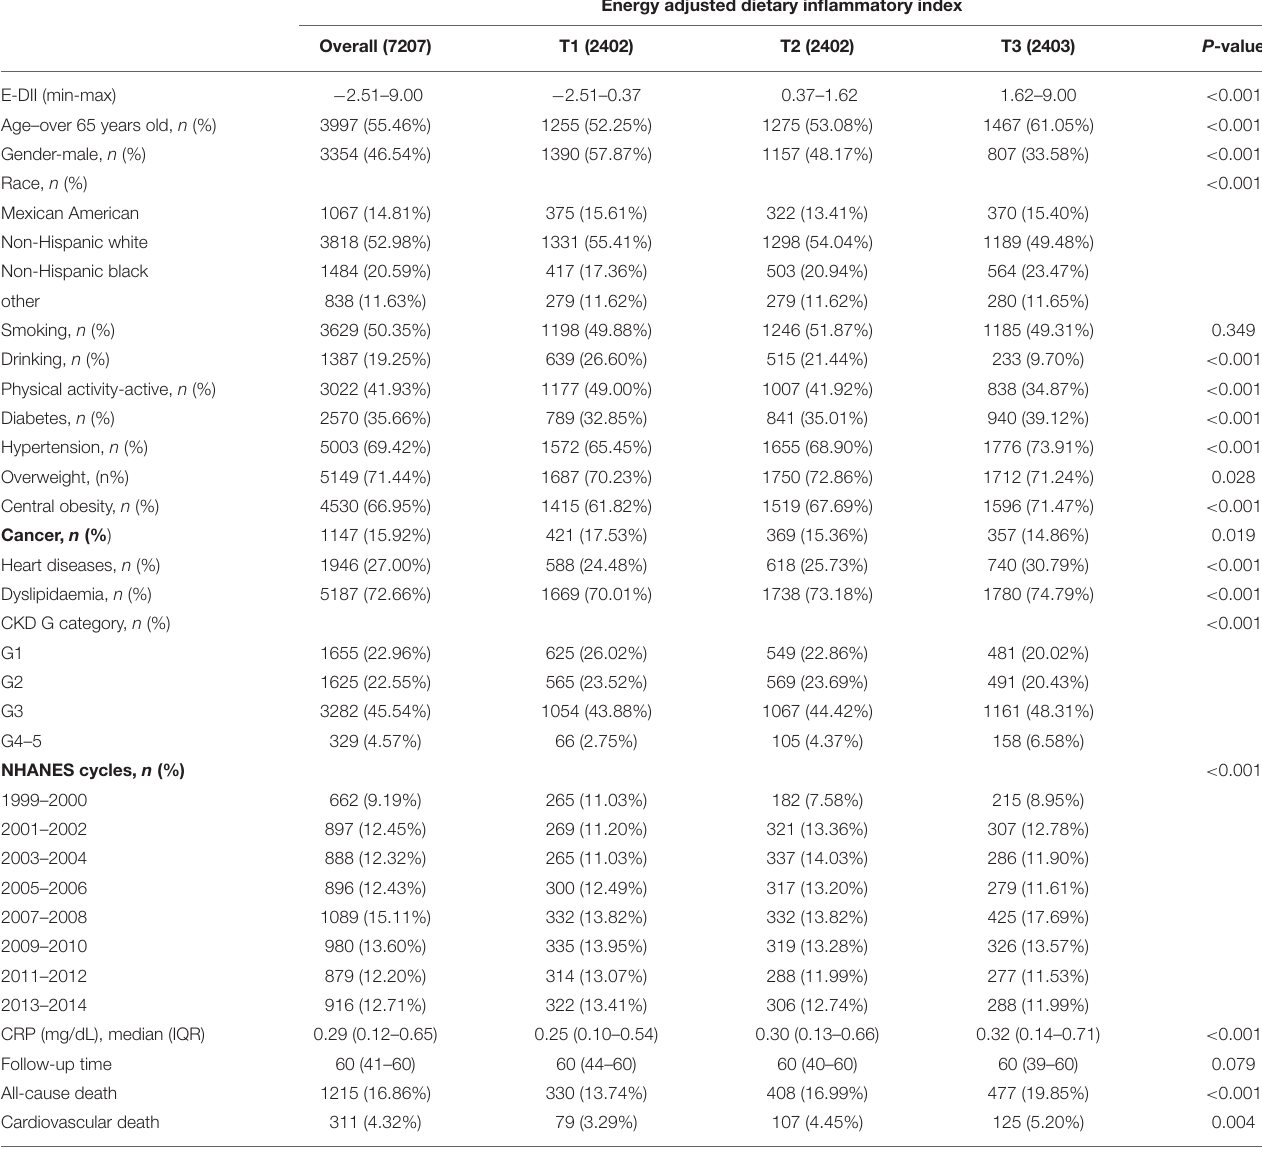
TABLE 1 | Characteristics of 7,207 chronic kidney disease (CKD) patients aged ≥ 20 years from 8 National Health and Nutrition Examination Survey (NHANES) cycles overall and by tertile of energy adjusted dietary inflammatory index